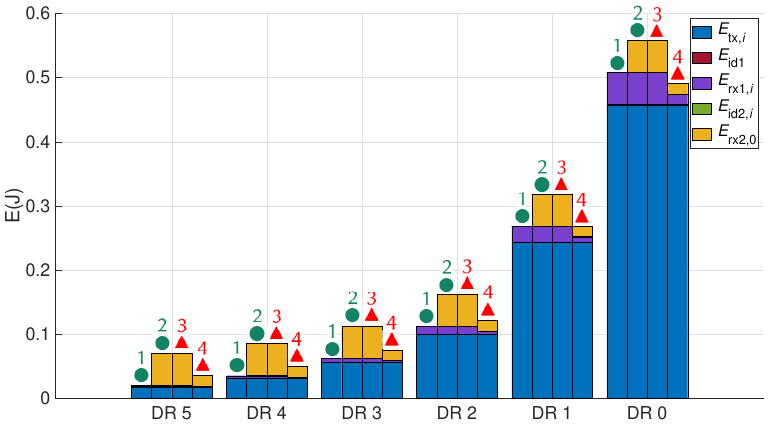
Figure 15. Total energy consumed by the